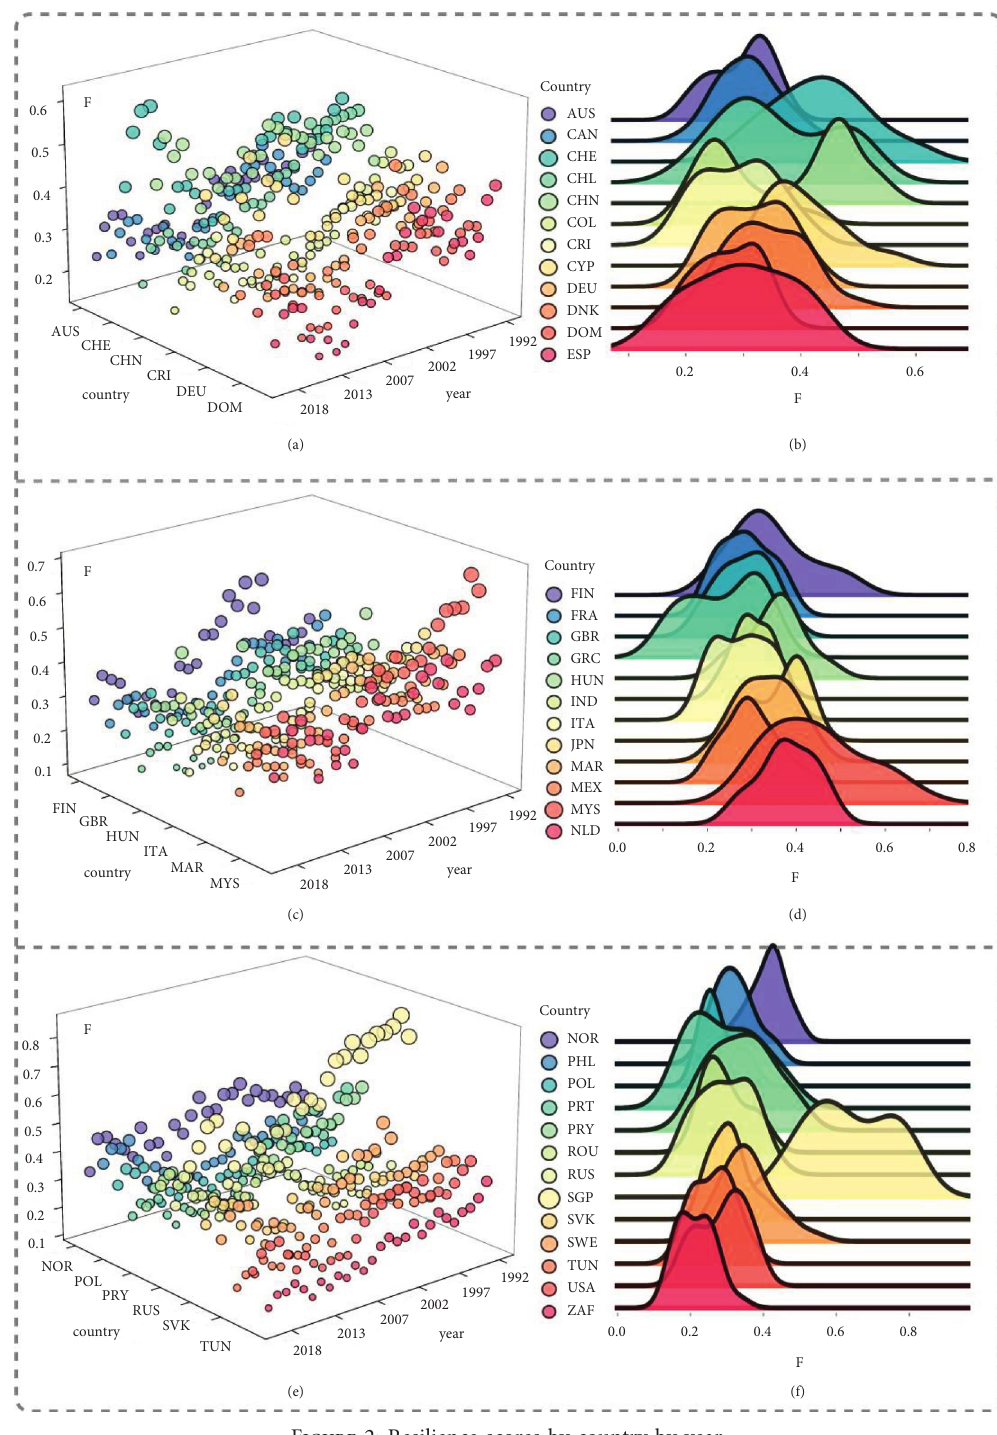
Figure 2: Resilience scores by country by